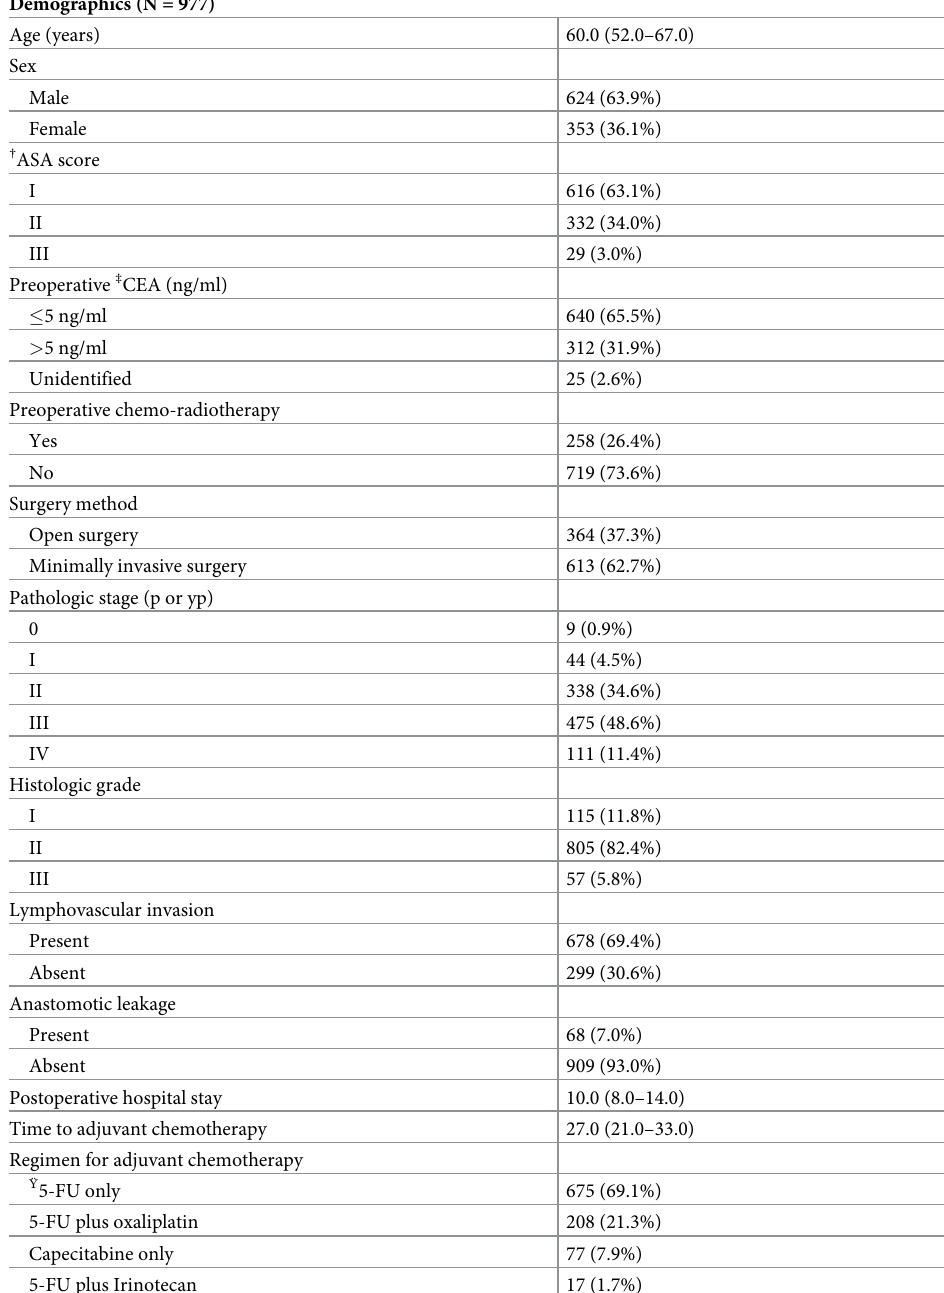
Table 1. Characteristics of all